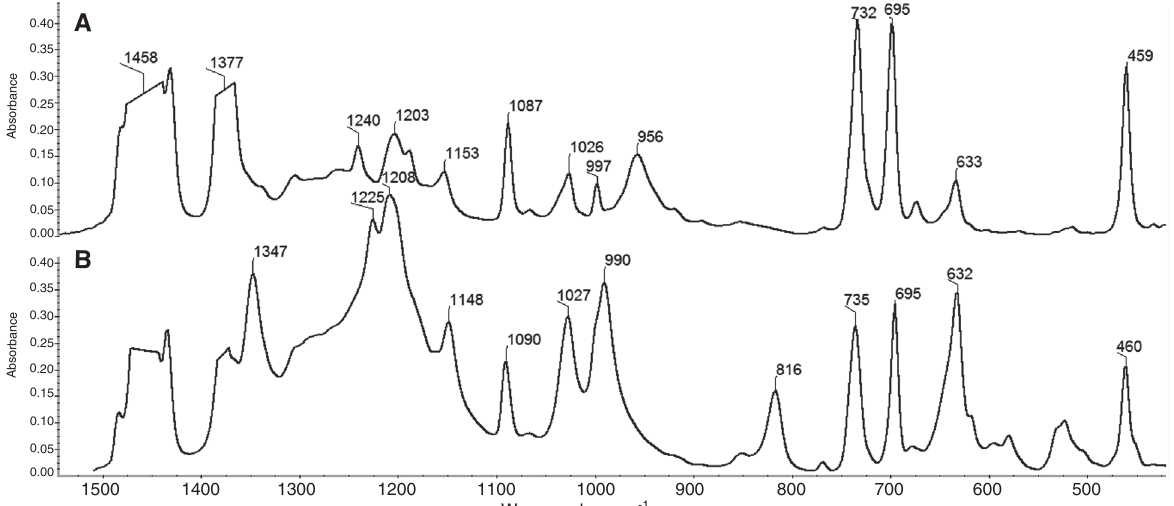
Figure 2 IR spectra of compounds 5 (A) and 5a (B) in Nujol. The bands of Nujol (1458 and 1377 cm -1 ) have been